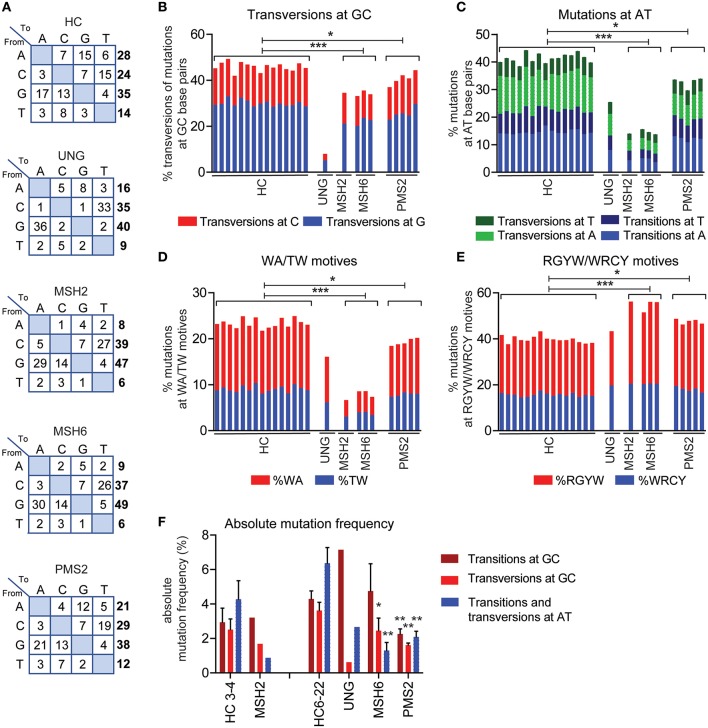
UNG and MMR deficiency result in changes in SHM patterns. (A) Transition tables of HCs, UNG-, MSH2-, MSH6-, and PMS2-deficient patients. The percentage of mutations at GC base pairs that are transversions (B) and the percentage of mutations at AT base pairs (C) in HCs and UNG-, MSH2-, MSH6-, and PMS2-deficient patients. The percentage of SHM present in WA/TW (D) and RGYW/WRCY motifs (E) in HCs and patients with genetic defects in MMR or BER. (F) Absolute frequency of mutations at AT base pairs and transitions and transversions at GC base pairs as compared to age-matched controls (n = 5 for age 3–4 and n = 10 for age 6–22). Statistical significance was performed using a Mann–Whitney test and indicated using *P < 0.05, **P < 0.01, and ***P < 0.001.